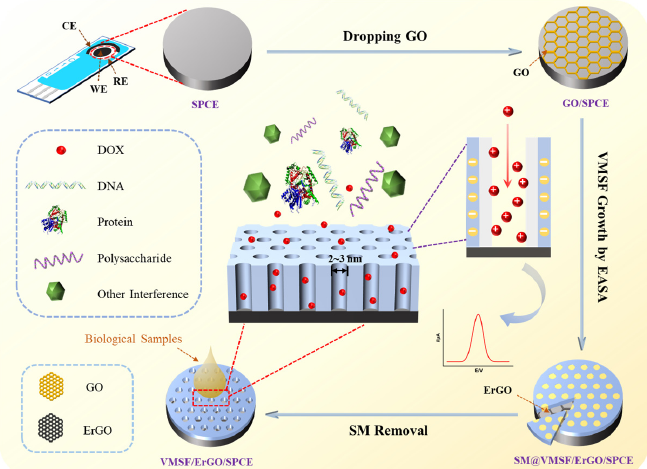
Figure 1. Schematic illustration for the preparation of VMSF/ErGO/SPCE and the direct detection of DOX in complex biological samples.